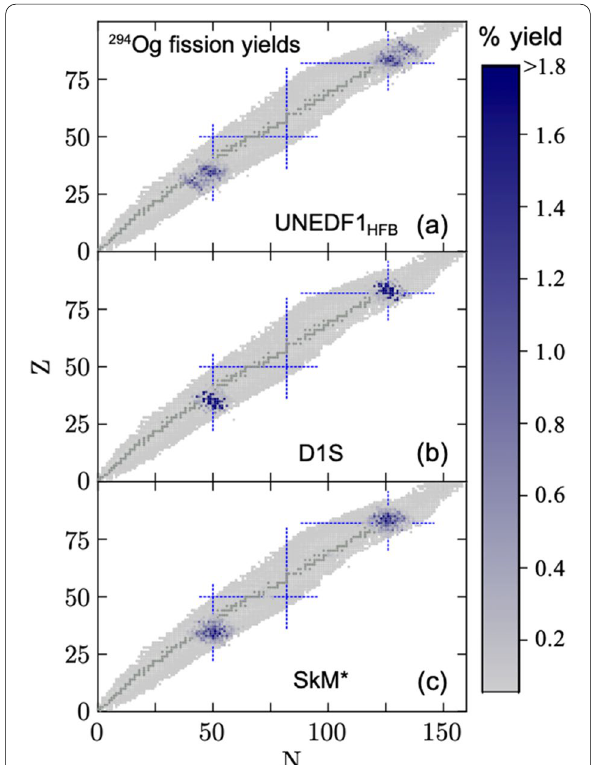
Fig. 11 Fission fragment distributions for 294 Og calculated with the three EDFs using the hybrid (WKB Langevin) model as discussed in + the text. Known isotopes are marked in grey. Magic numbers 50, 82, and 126 are indicated by dotted lines. The figure is adapted from